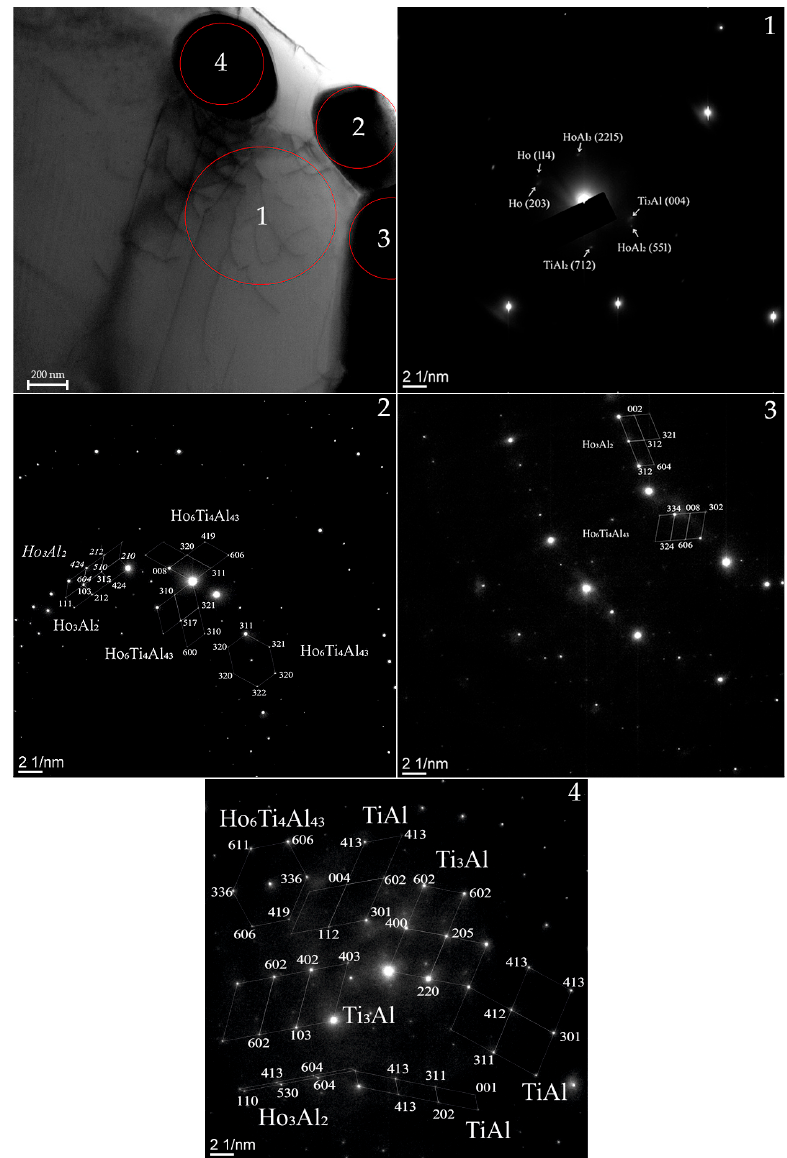
Figure 6. TEM patterns of the TAD alloy, selected area electron diffraction (SAED) patterns of the TAD alloy in the relevant region